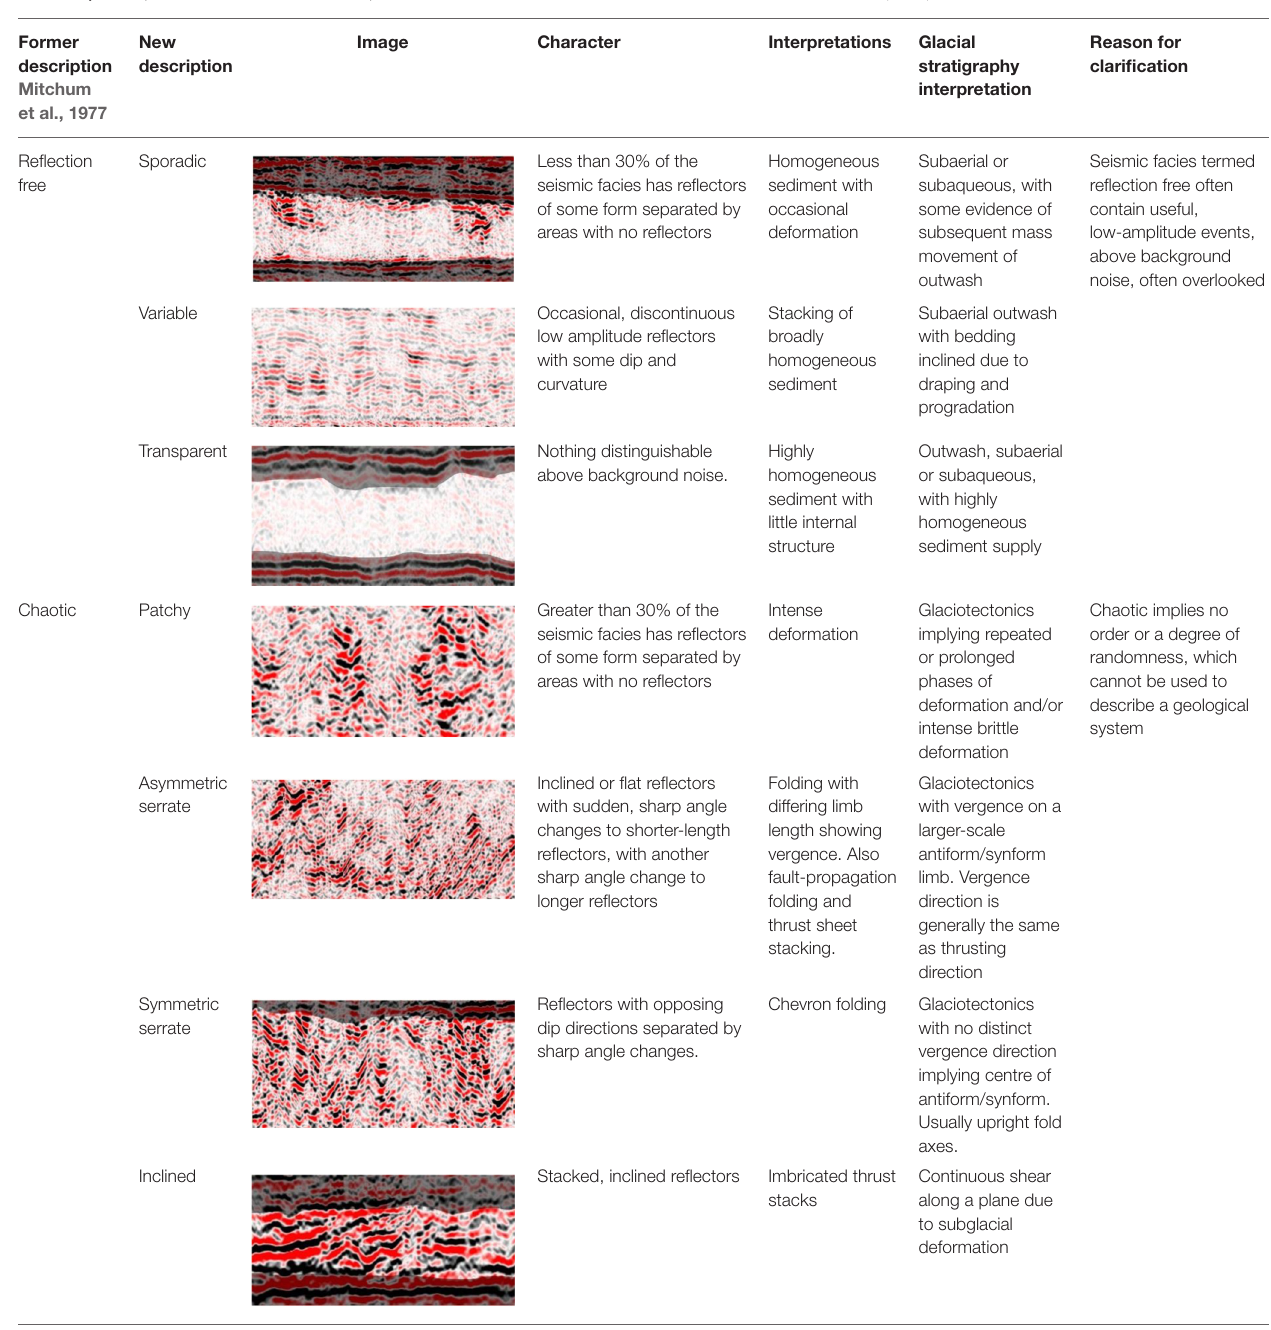
TABLE 2 | Description of new seismic facies expanded from the terms “reflection-free” and “chaotic” Mitchum et al.